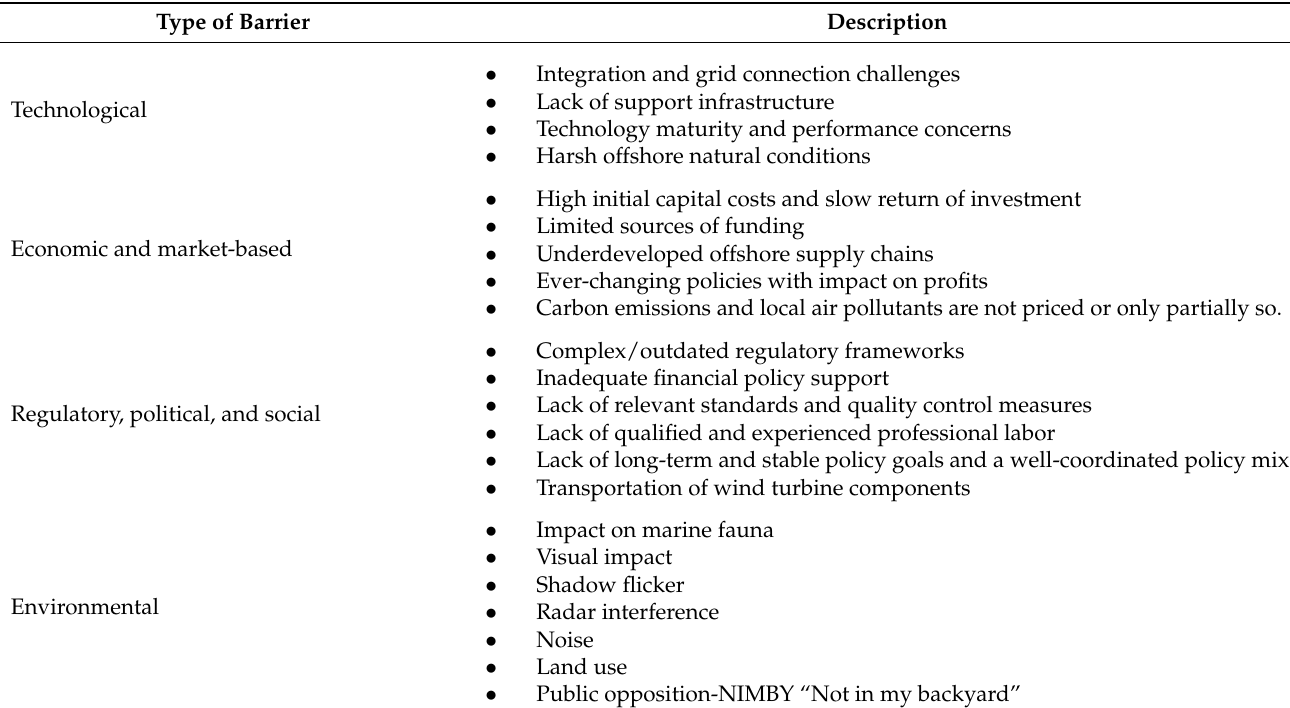
Table 1. Barriers to the development of the wind energy